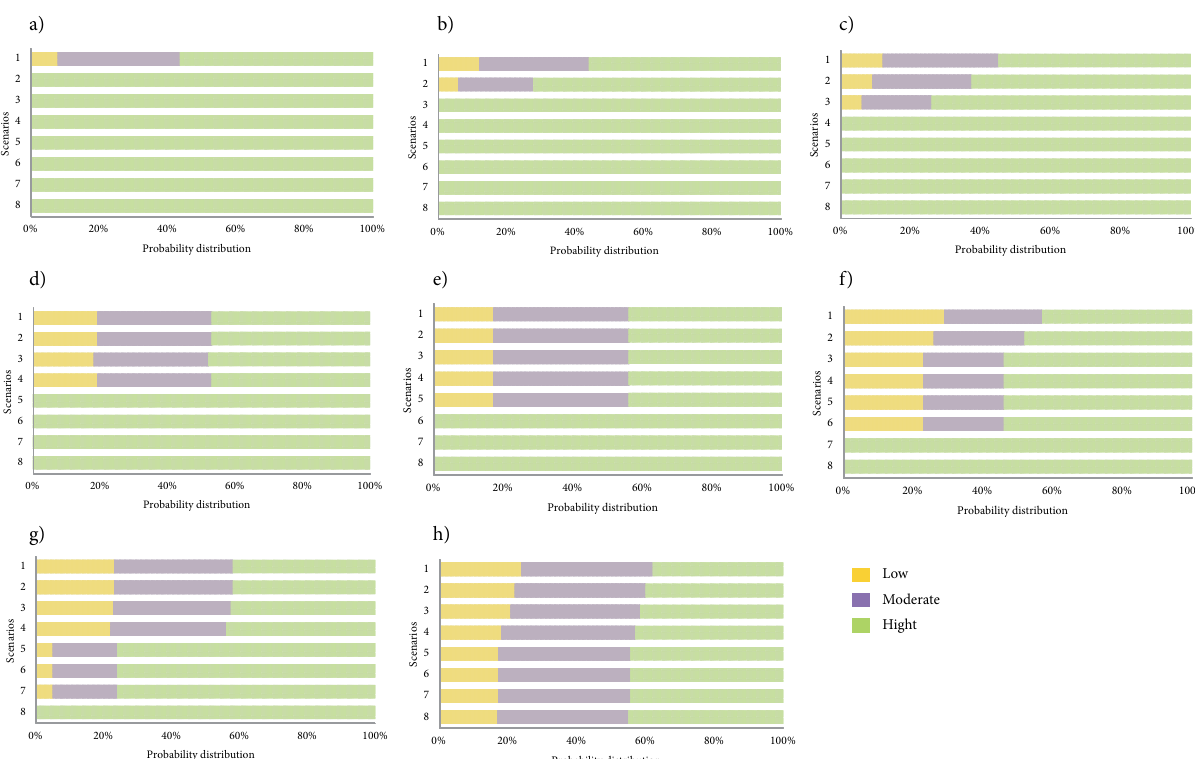
Figure 7. Probability distribution of the eight factors in diagnostic analysis under different scenarios: (a)TAC1; (b) TAC3; (c) TAC2; (d) OC2; (e) GC1; (f) EC4; (g) OC1; and (h)